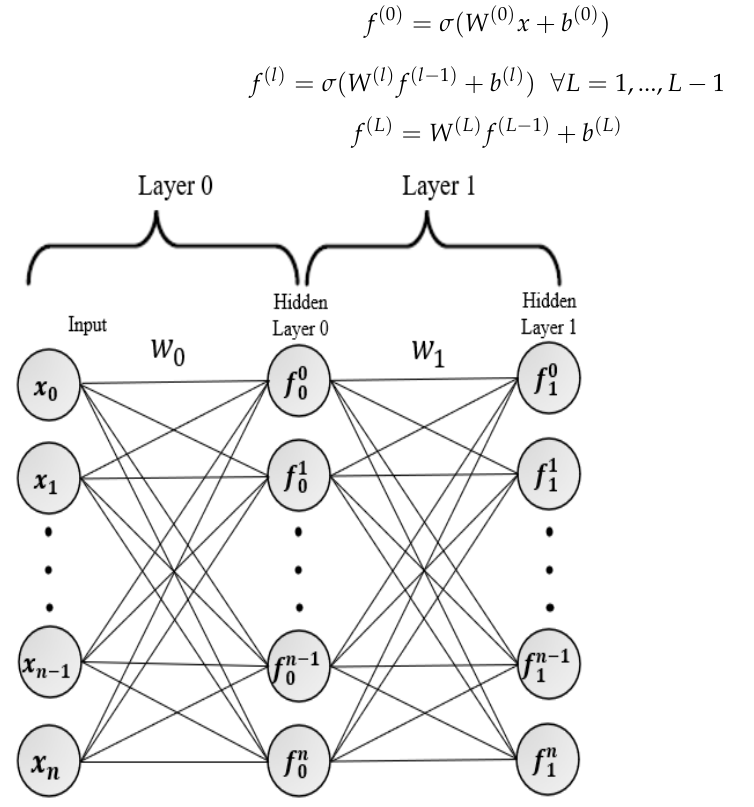
Figure 1. A 2 layer MLP